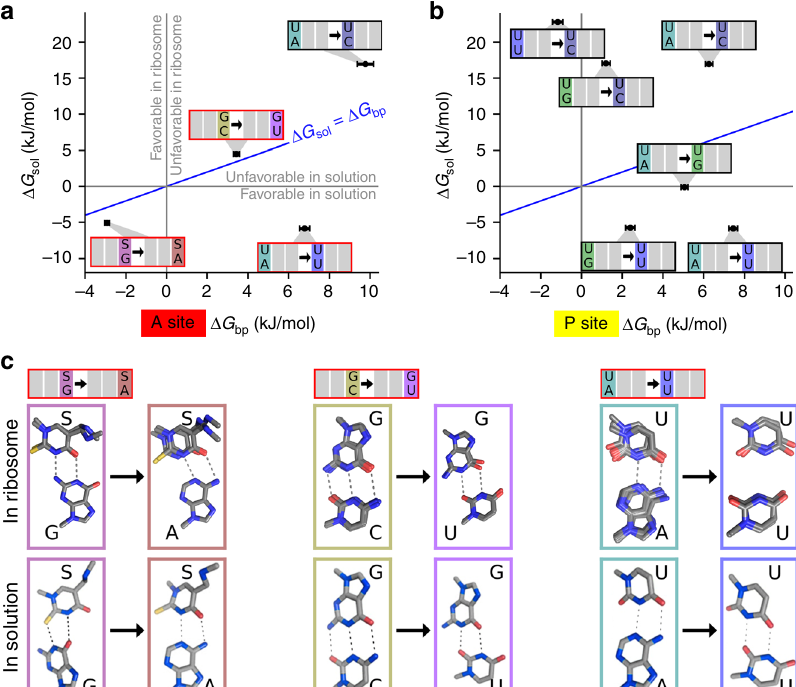
Fig. 6 Base pairs in solution and on the ribosome. a In the A site. Free energy of base pairs in solution, Δ G sol , was estimated from MD simulations 40 . For Δ G bp values, the mean (circle) and standard deviation (bar) of the probability densities is shown (from Fig. 2a). Gray lines (at given base pair change is favorable or unfavorable. Blue line separates the regions where the interaction is more favorable on the ribosome (above the line) or in solution (below). b In the P site. c Upper row, base-pair conformations in the A site from X-ray structures 27,34 . Lower row, the minimum free-energy conformation for the same base pairs in solution (adapted from Vendeix et al. 40